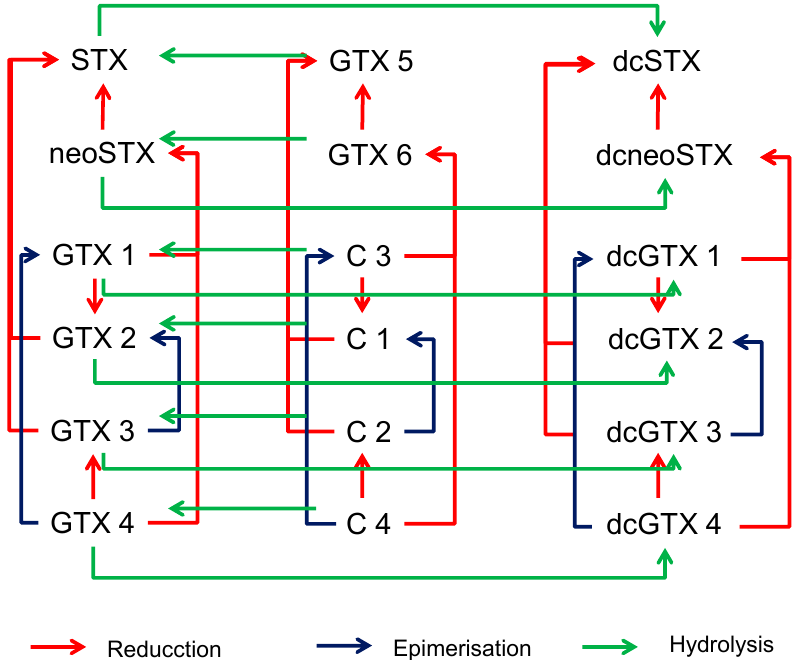
Figure 8. Diagram of the bioconversion pathways detected in molluscs contaminated with STX-group toxins. Adapted from Guéguen et al. [65].